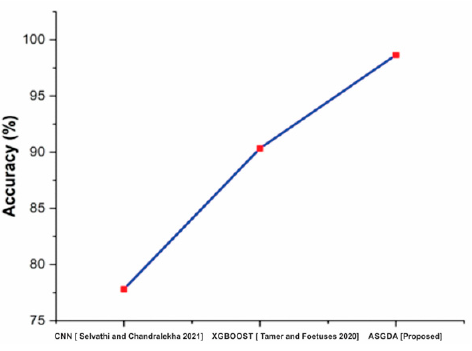
Figure 8. Comparison of accuracy with the traditional and proposed method [42,43].